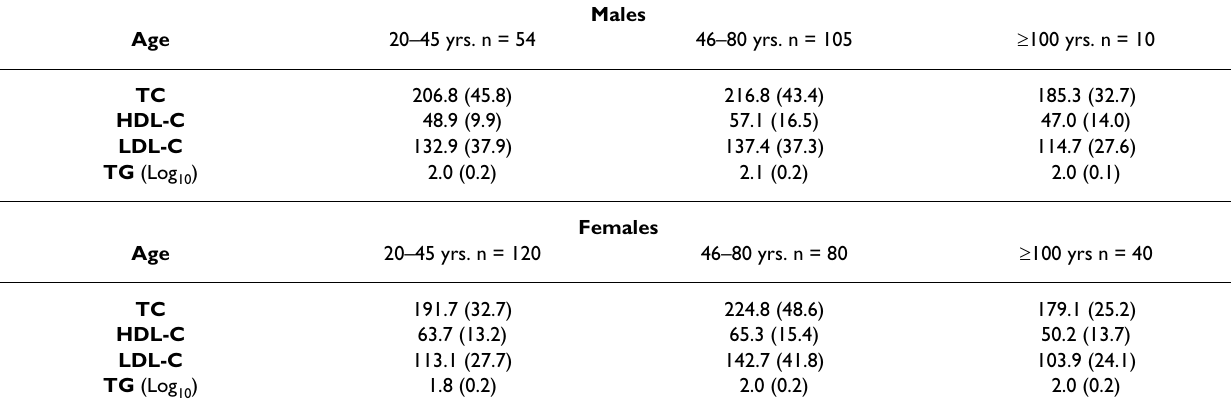
Table 3: Lipidemic parameters (mg/dL) in the sample of healthy subjects stratified for age. Mean values with standard deviation in parenthesis.